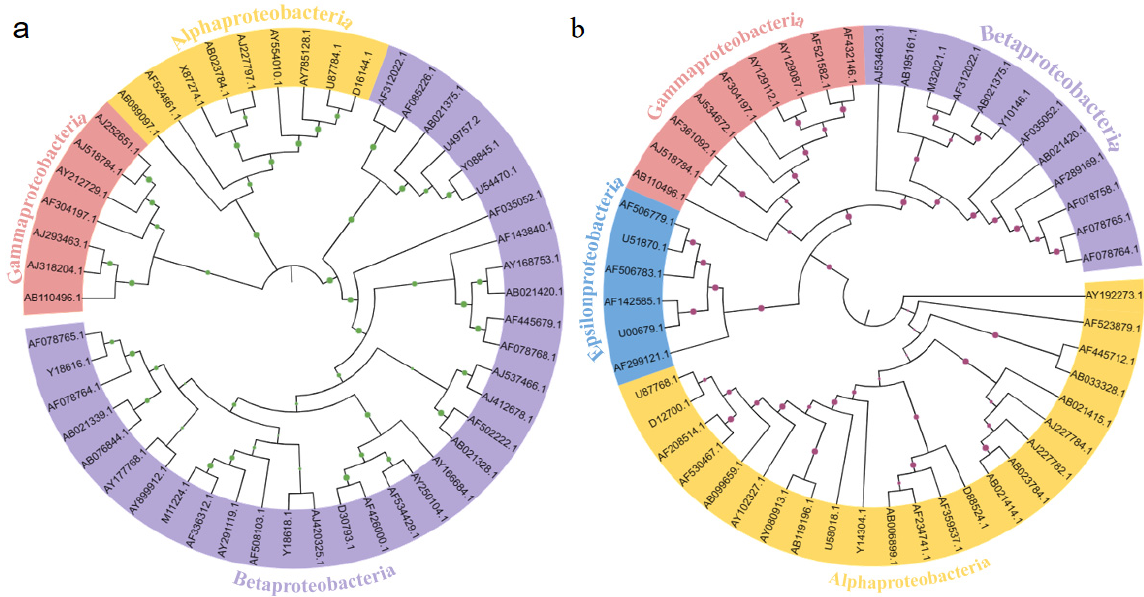
Figure 6. Phylogenetic relationships of 50 dominant Proteobacteria sequences retrieved from MBfRs with different operation times: ( a ) 30 days, and ( b ) 60 days.